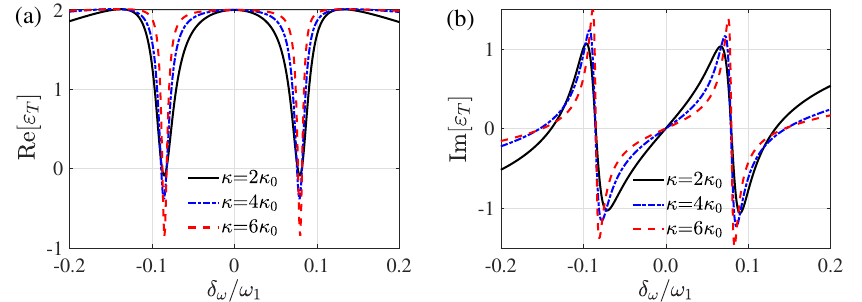
Figure 3. ( a ) The absorption property Re[ ε T ] and ( b ) the dispersion property Im[ ε T ] as functions of the normalized frequency δ ω / ω 1 for the different cavity decay rates. We set P = 2 mW, and the other parameters are the same as given in Figure